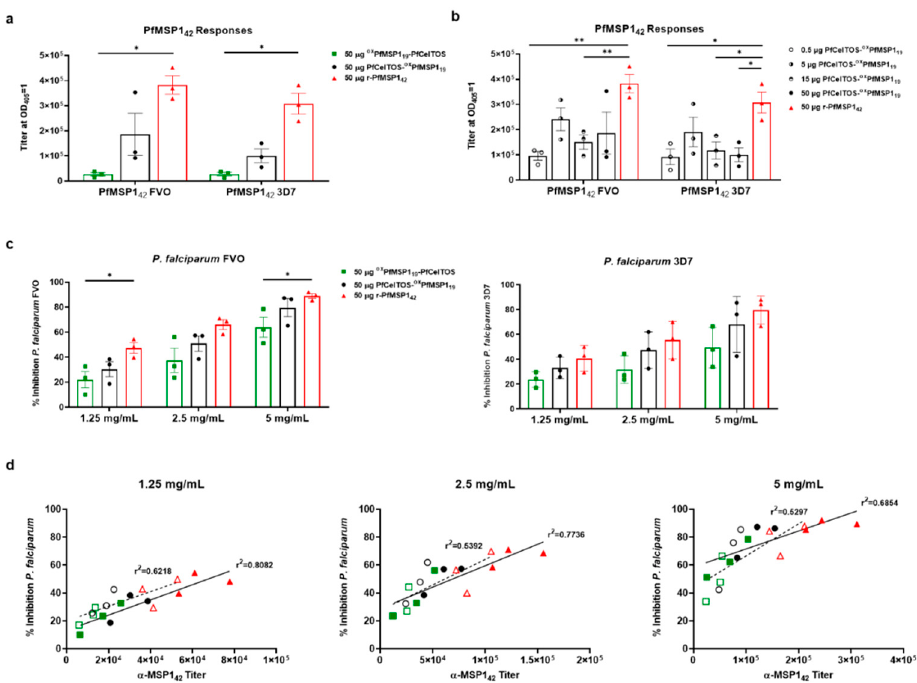
Figure 4. SAPN induces antibodies that inhibit parasites in vitro. Two weeks following the third I.M. immunization, rabbits were exsanguinated, and serum antibody titers were measured against recombinant proteins and blood-stage parasites. ( a ) Fifty micrograms dose response of PfCelTOS- ox PfMSP1 19 (n = 3), ox PfMSP1 19 ‐ PfCelTOS (n = 3), and rPfMSP1 42 (n = 3) to the Vietnam Oak ‐ Knoll (FVO) and 3D7 PfMSP1 42 antigens. ( b ) PfCelTOS- ox PfMSP1 19 dose-response relationship compared to the previous 50 µ g PfCelTOS- ox PfMSP1 19 and rMSP1 42 groups. ( c ) Total IgG was normalized to 1.25, 2.5, and 5 mg/mL. Fifty micrograms of each SAPN construct and rPfMSP1 42 were tested for FVO and 3D7 parasite-specific growth inhibition by measuring the amount of parasite lactate dehydrogenase present. ( d ) Correlation graphs between purified IgG ELISA titer and percent inhibition at 1.25, 2.5, and 5 mg/mL with linear regression analysis. FVO strain titer and percent inhibition are represented by filled symbols and a solid trend line, while 3D7 strain titer and percent inhibition are represented by open symbols with a dash trend line. Note: there are overlapping symbols on the 2.5 mg/mL graph, where an ox PfMSP1 19 -PfCelTOS sample has nearly identical titer (12,587, 11,760) and identical percent inhibition (23.6) for both FVO and 3D7 strains, respectively. Data are shown as the mean with +/ − standard error of the mean. Statistical significance was determined using nonparametric multiple t test, the Holm–Sidak method comparing to the rPfMSP1 42 standard group with *: p < 0.05; **: p < 0.01. Differences in PfMSP1 42 strain responses were compared